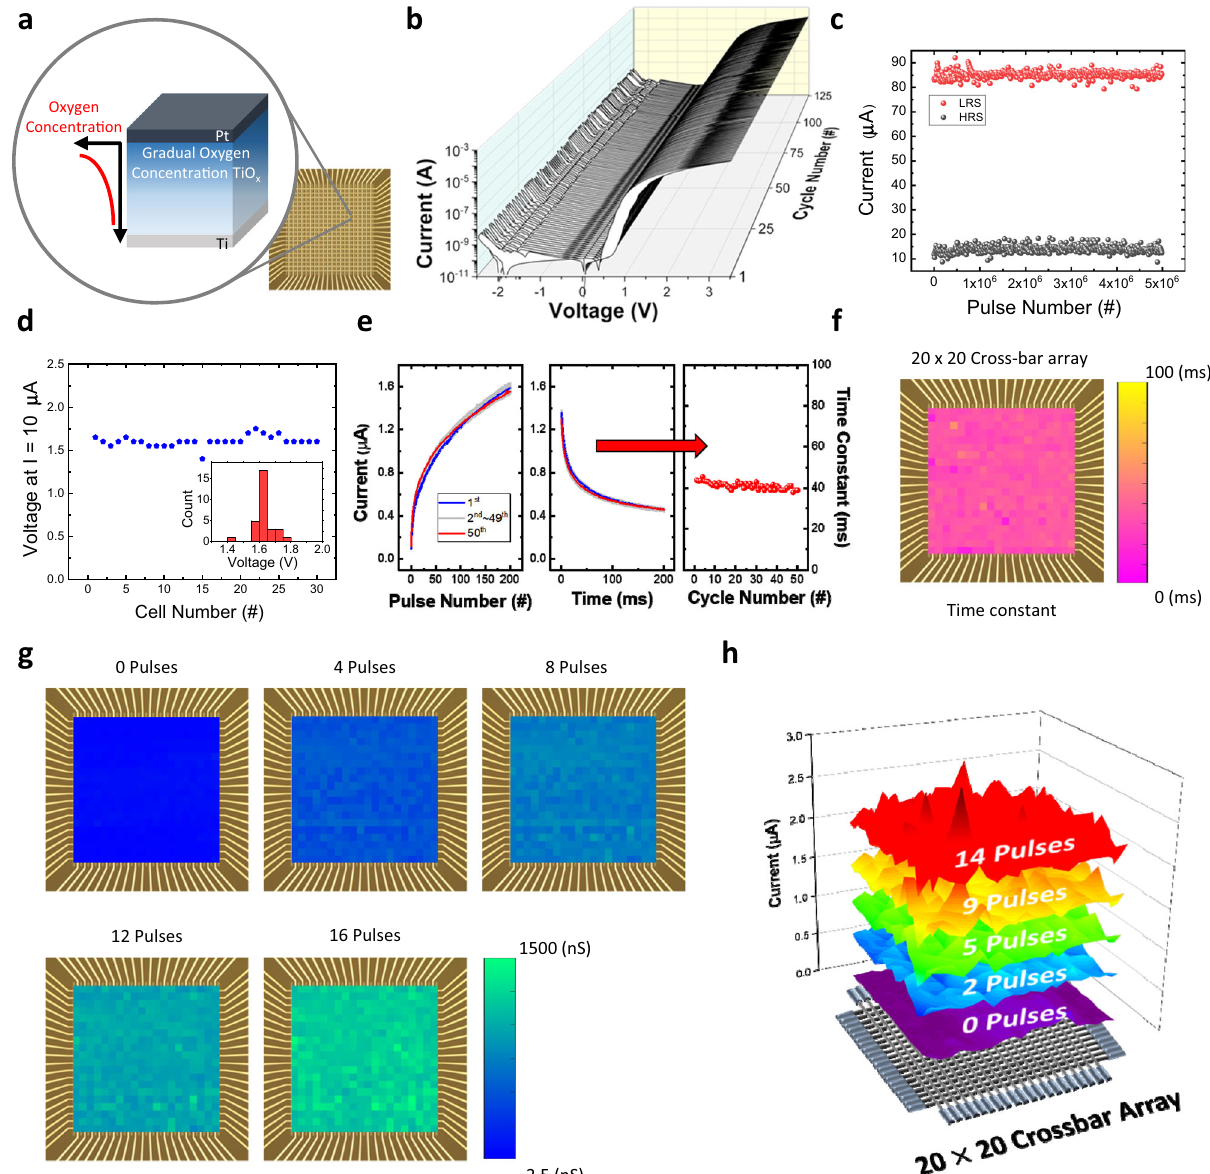
Fig. 1 The structure of gradual TiO x memristor and its electrical characteristics. a Schematic of Pt/gradual TiO x /Ti memristor structure showing gradual oxygen concentration in the TiO x layer. b Consecutive 125 I – V sweep curves of the device showing very small temporal variation (1.39%) during the cycles. c Endurance test showing 5 × 10 6 consecutive set/reset pulse without degradation. d Spatial variation (3.87%) calculated through DC voltage sweep in the 30 stand-alone devices. e Fifty consecutive cycles of the pulsed response of a single stand-alone device. A single cycle is composed of 200 set pulse responses (4.5 V, 10 µ s) and following self-decaying during 200 ms with a 40 ms decaying time constant. f A 2D map for the decay time constant of 400 devices in a 20 × 20 cross-bar array. g Analog conductance change in a 20 × 20 cross-bar array with 0, 4, 8, 12, and 16 set pulses (4.5 V, 100 µ s). h A 3D representation of the conductance change along with the set